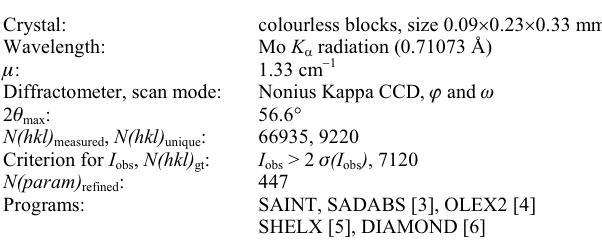
Table 1. Data collection and handling.